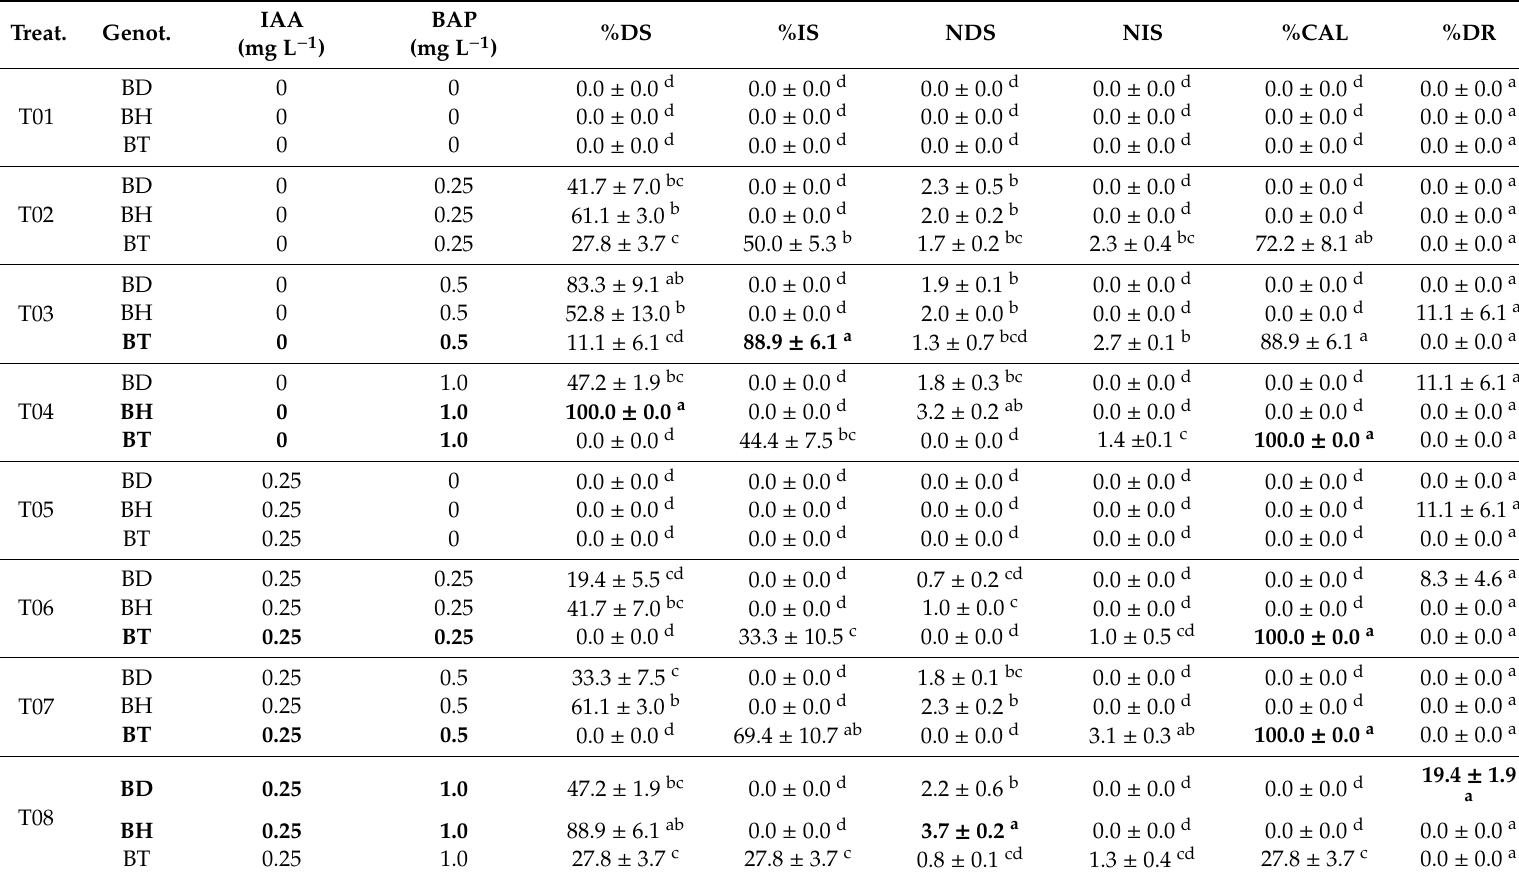
Table 3. Results from organogenesis on Bryophyllum spp. cultured in vitro. The results for each output were expressed as the mean ± standard error ( n = 12). Di ff erent letters indicate significant di ff erences ( p < 0.01). Bold values indicate the maximum value for each output.